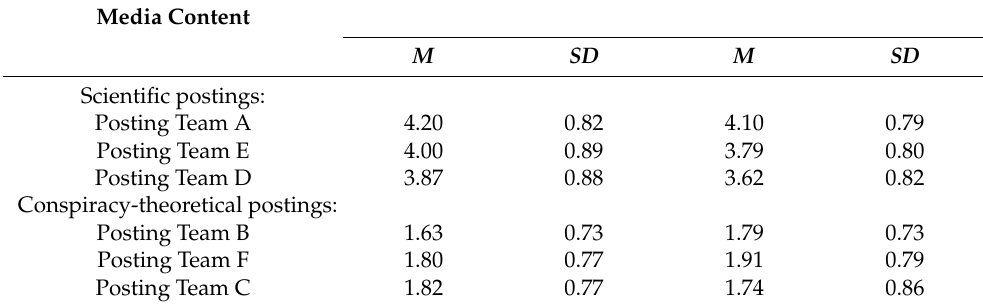
Table A1. Selection of the predictor variable media